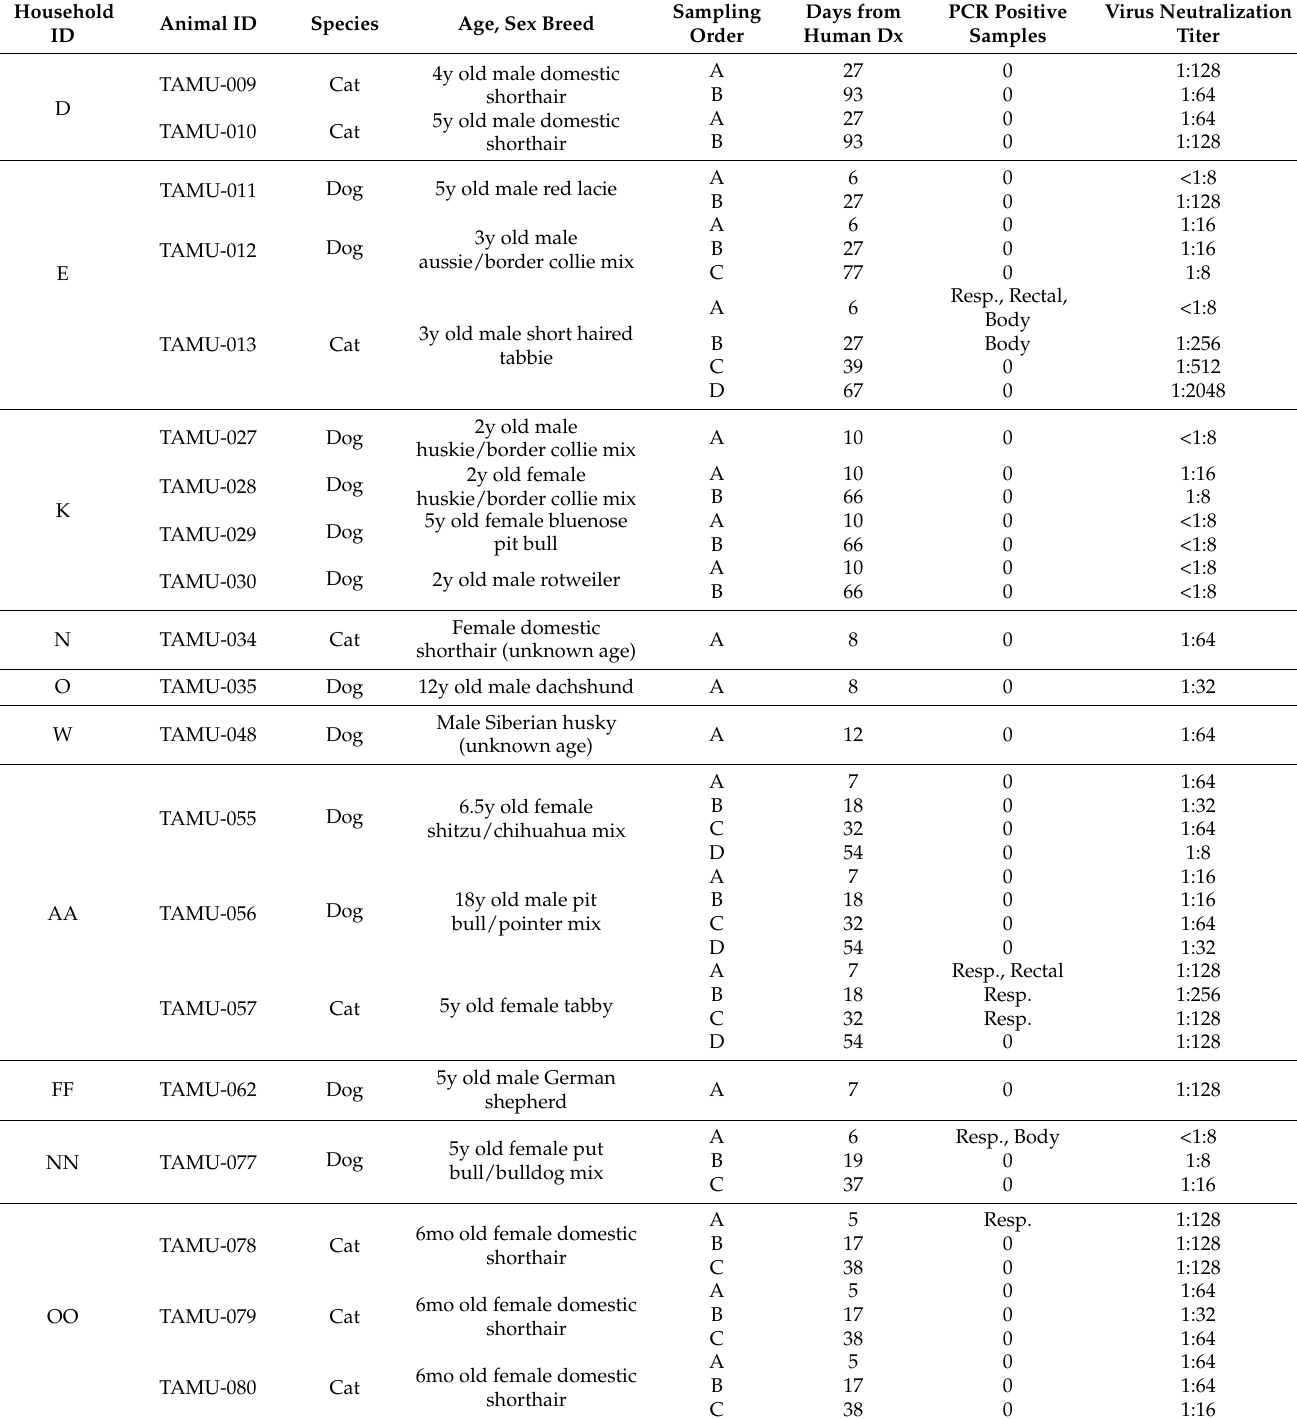
Table 3. Pets with SARS-CoV-2 neutralizing antibody titers from households with at least one confirmed case of human COVID-19 in Brazos County, Texas, at first (A) and subsequent (B–D) sampling visits from June-September, 2020. All households with at least one VN-positive animal are shown, with all animals living in the household tested one or more times. For the column of PCR results, any positive PCR result in any of the screening or confirmatory assays is considered